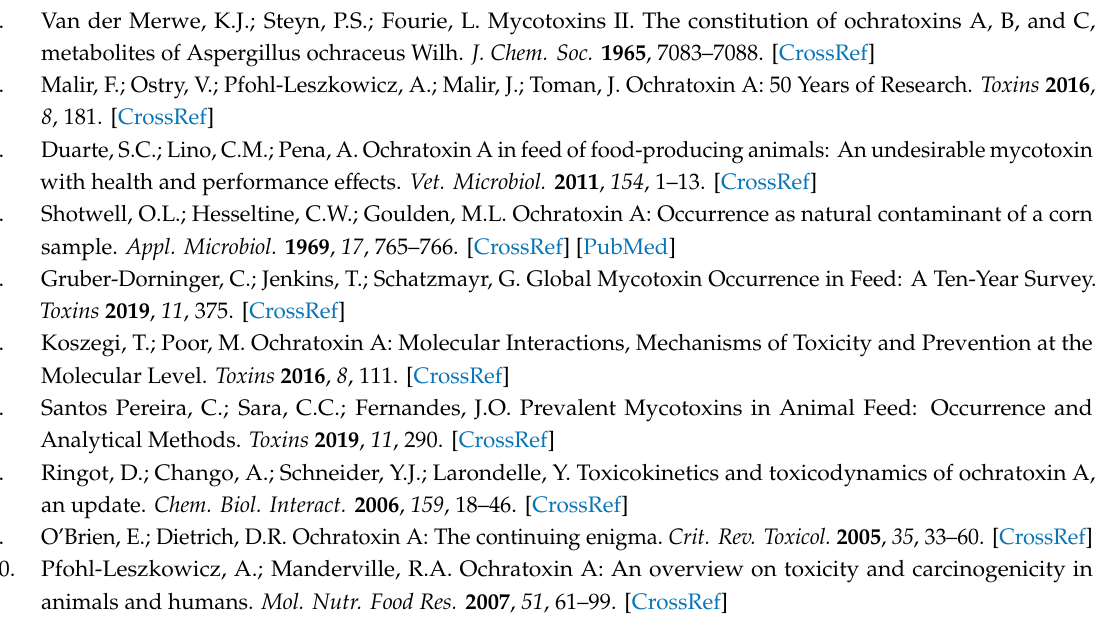
Supplementary Materials: The following are available online, Figure S1: Feed conversion of C57BL / J mice from day 1 to day